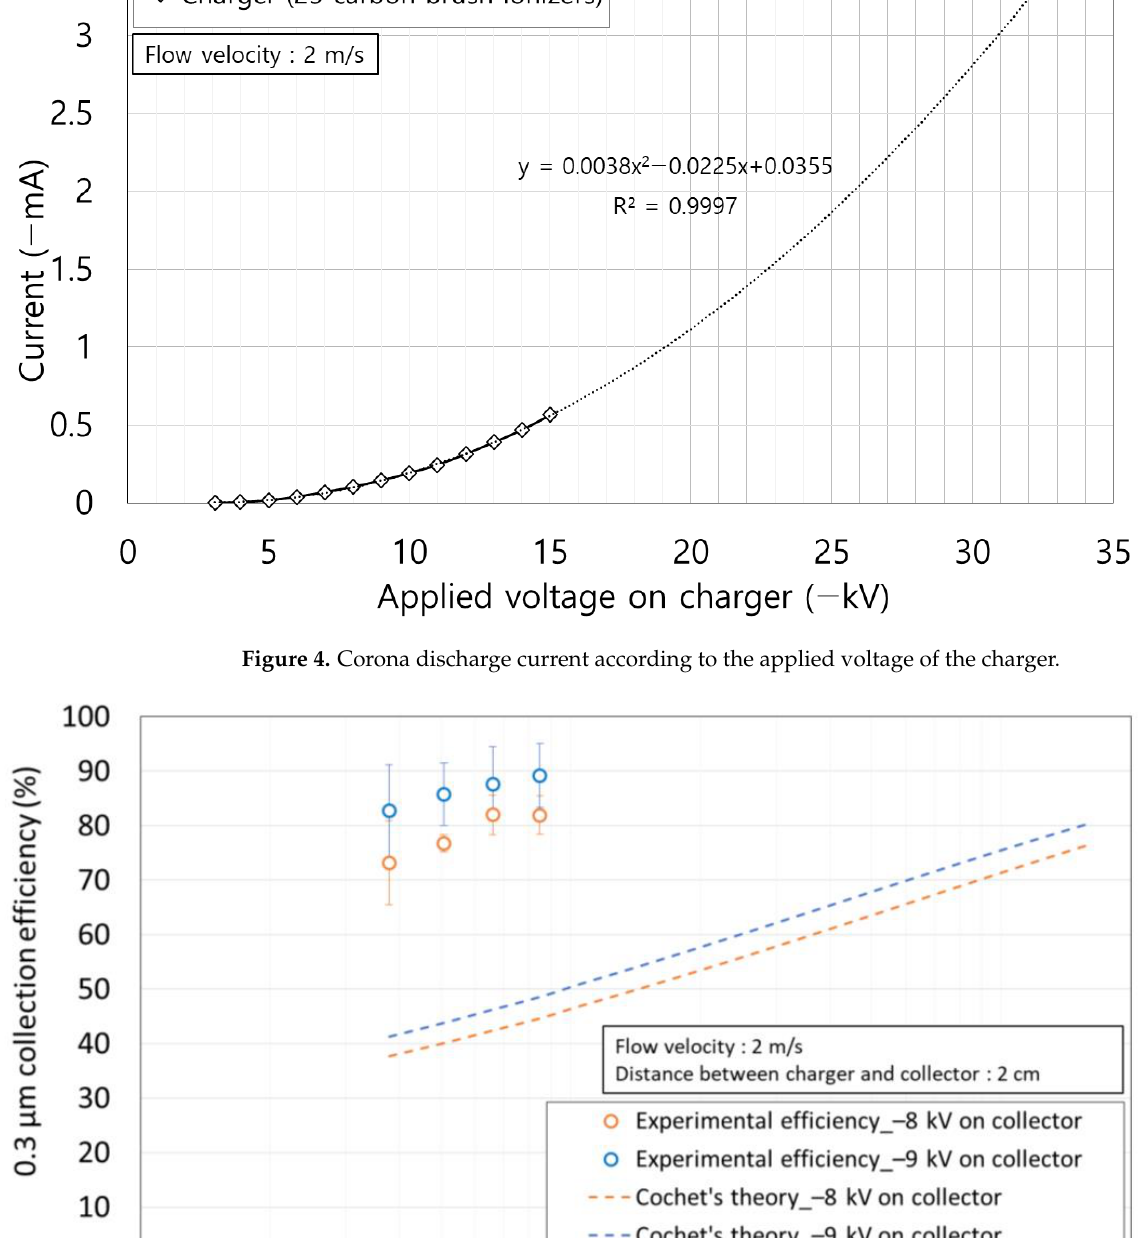
Figure 4. Corona discharge current according to the applied voltage of the charger.